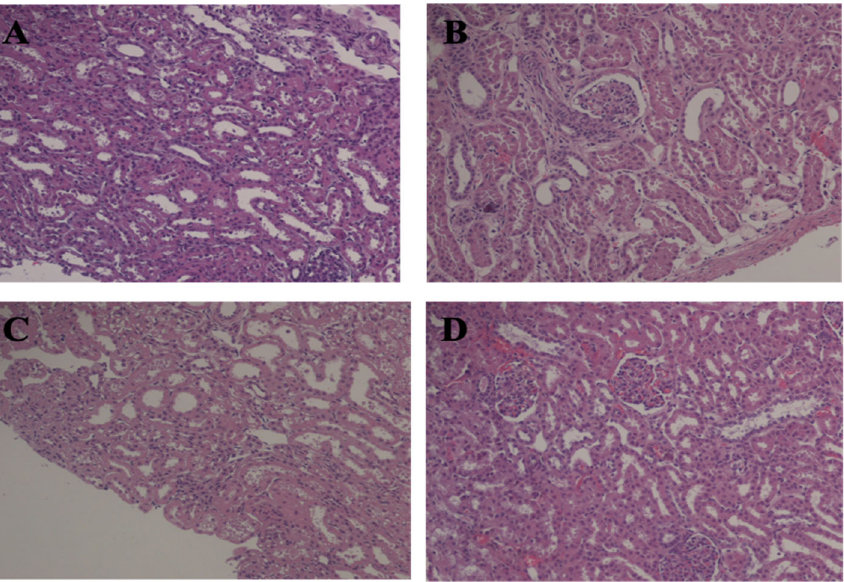
Figure 7. Histological examination. Representative light microscopy images of kidney tissue samples from SCS at T2 ( A ) and Tend ( B ) and HMP groups at T2 ( C ) and Tend ( D ). Magnification ×100.